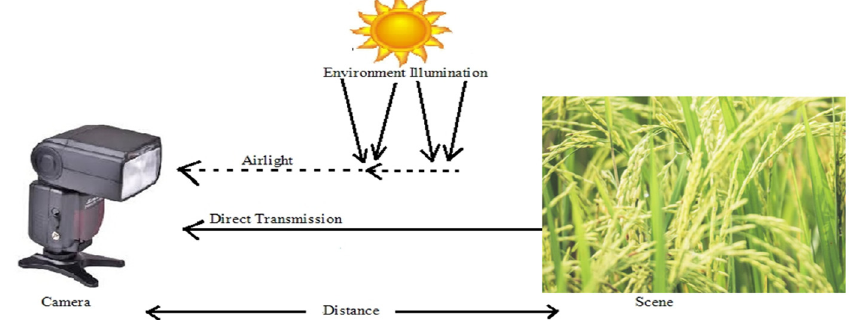
Figure 5: Optical scattering in the